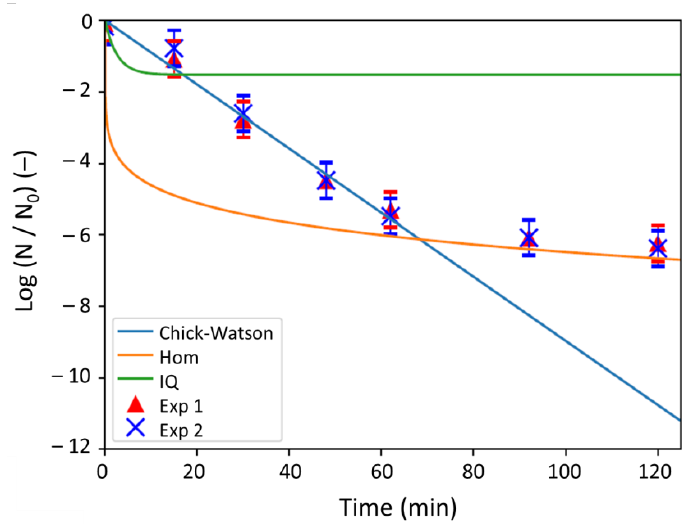
Figure 5. Kinetics of E. coli bacterial removal by Ag + ions, obtained by the experiments (Exp 1 and Exp 2, respectively) and the models (Chick–Watson, Hom, and IQ).